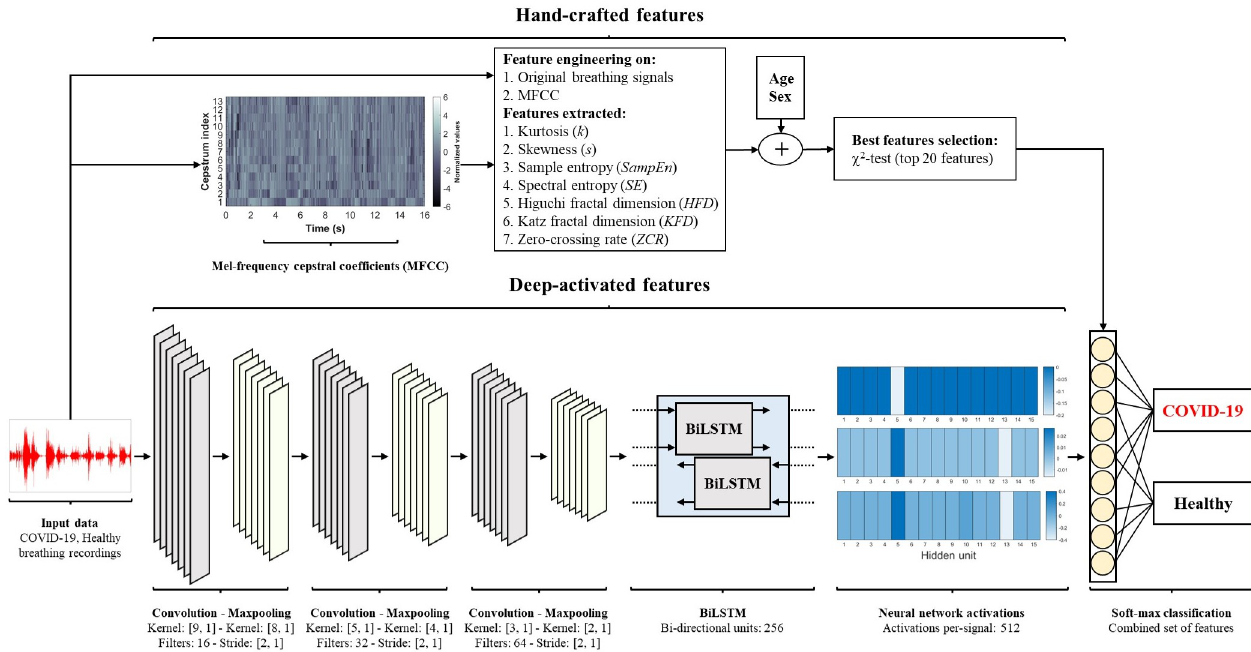
Fig 4. The framework of deep learning followed in this study. The framework includes a combination of hand-crafted features and deep-activated features. Deep features were obtained through a combined convolutional and recurrent neural network (CNN-BiLSTM), and the final classification layer uses both features sets to discriminate between COVID-19 and healthy